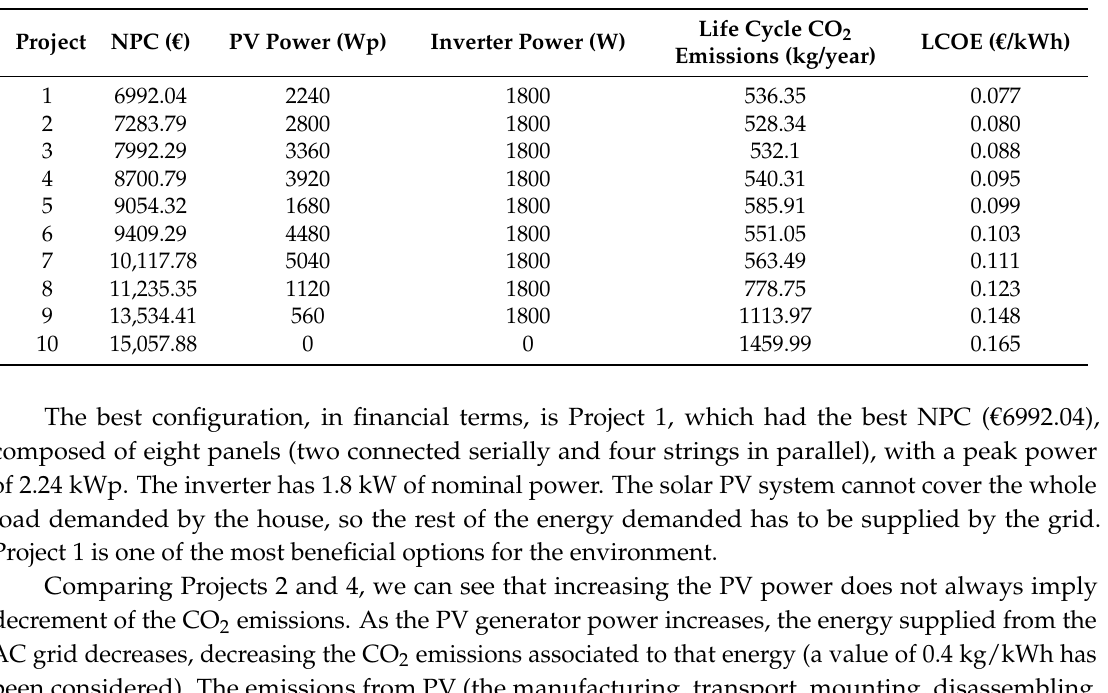
Table 5. Project results given by iHOGA. Solar PV on net-metering